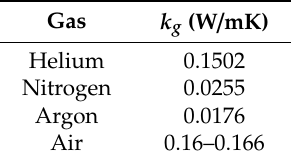
Table 1. Thermal conductivity of the common gas atmosphere [38,40].